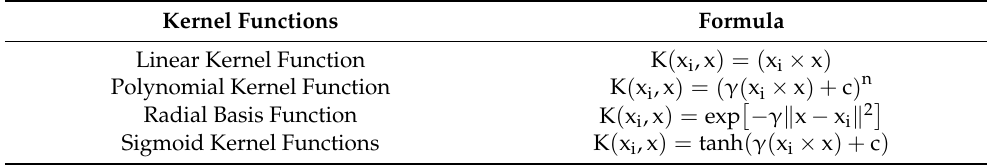
Table 4. Common kernel functions. Kernel Functions Formula Linear Kernel